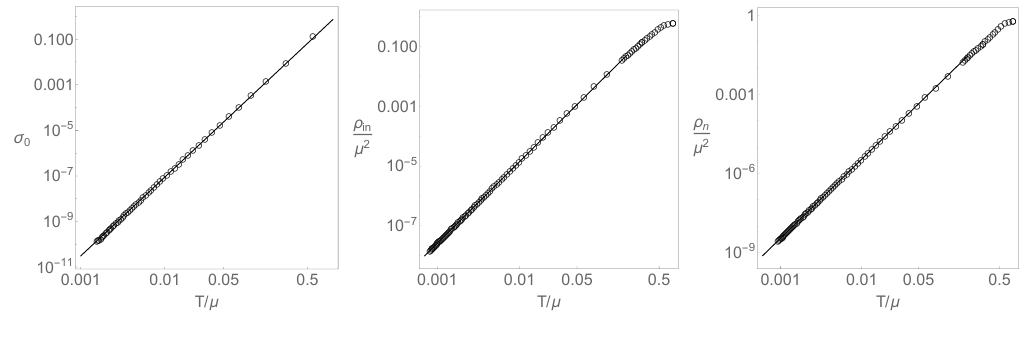
Figure 1 . z = 1 : σ 0 ∼ # T 3 . 46 , ρ in ∼ # T 2 . 73 , ρ n ∼ # T 3